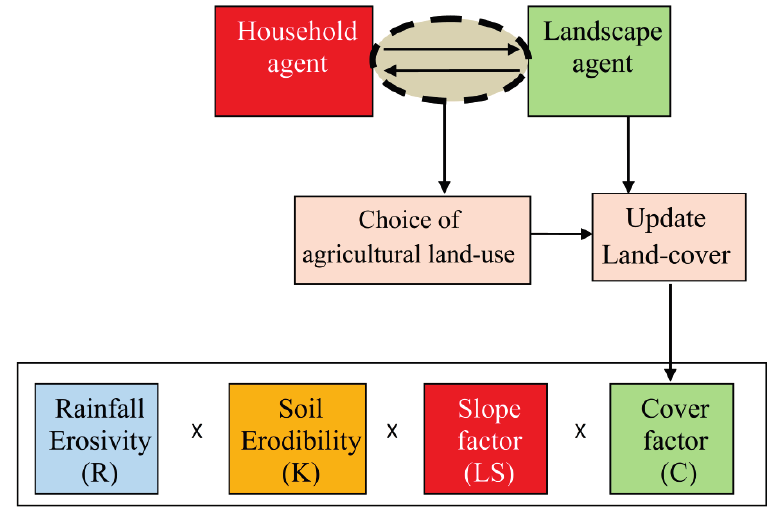
Figure 3. Soil loss